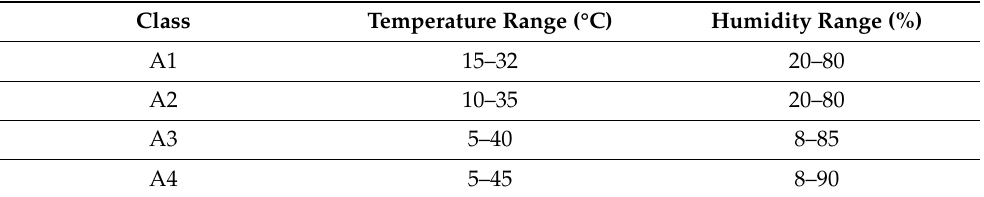
Table 3. Four classes of data centers according to